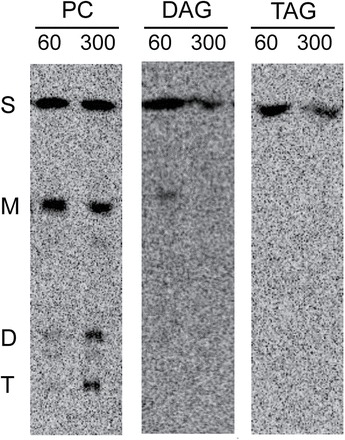
Unsaturated [14C]fatty acids are not incorporated into triacylglycerol after a pulse–chase labelling experiment. Fatty acid methyl esters after 60min (end of pulse) and 300min (end of chase) of PC, DAG, and TAG separated by argentation TLC. Each lane was loaded with radioactivity corresponding to 10 kdpm. PC, phosphatidylcholine; DAG, diacylglycerol; TAG, triacylglycerol; S, saturated FA; M, mono-unsaturated FA; D, di-unsaturated FA; T, tri-unsaturated FA. Representative autoradiograms of TLC plates are shown.